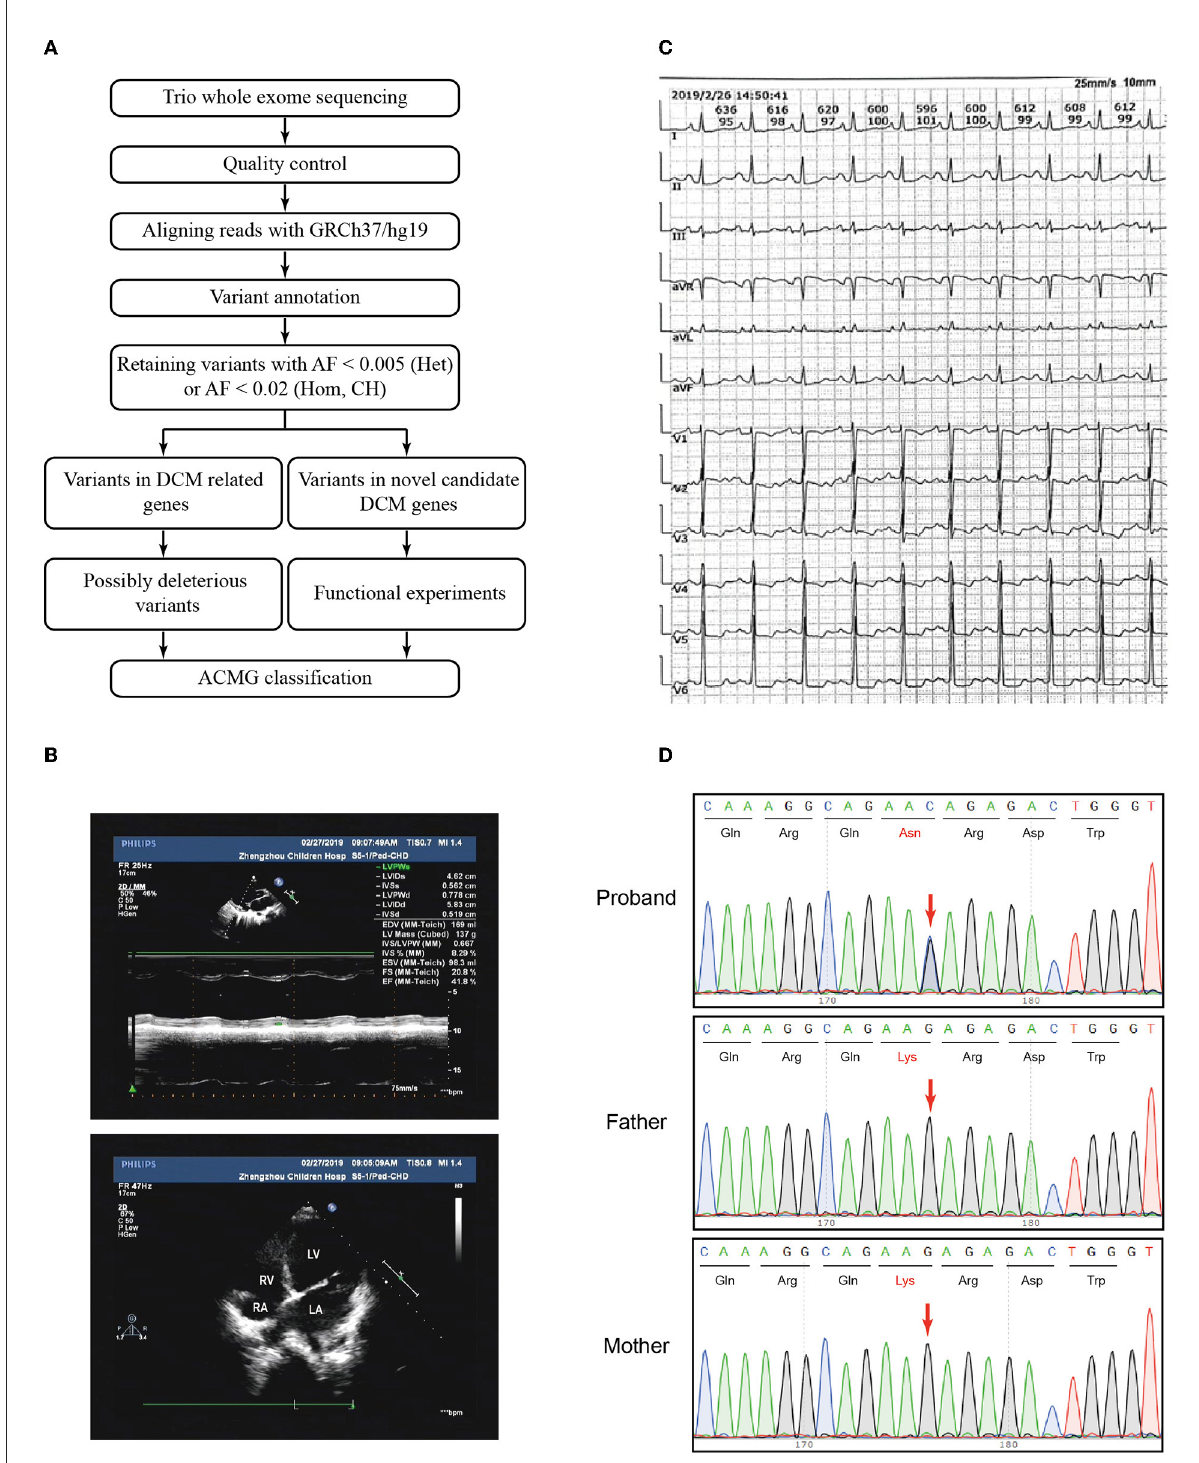
FIGURE1 Variant filtration workflow and the phenotype of the patient. (A) Variant filtration workflow employed in this study. AF: allele frequency; Het, heterozygous; Hom, homozygous; CH, compound heterozygous; DCM, dilated cardiomyopathy; ACMG, American College of Medical Genetics and Genomics. (B) The echocardiography showed an apical four-chamber view of the proband’s indicating dilation of the right ventricle. RV, right ventricle; RA, right atrium; LV, left ventricle; LA, left atrium. (C) Electrocardiogram (ECG) showed sinus rhythm, P wave changes, and ST-T changes. (D) Sanger sequencing confirmed that the variant CDH2 c.474G > C was heterozygous in the proband and not inherited from her parents. The arrows indicated the mutated